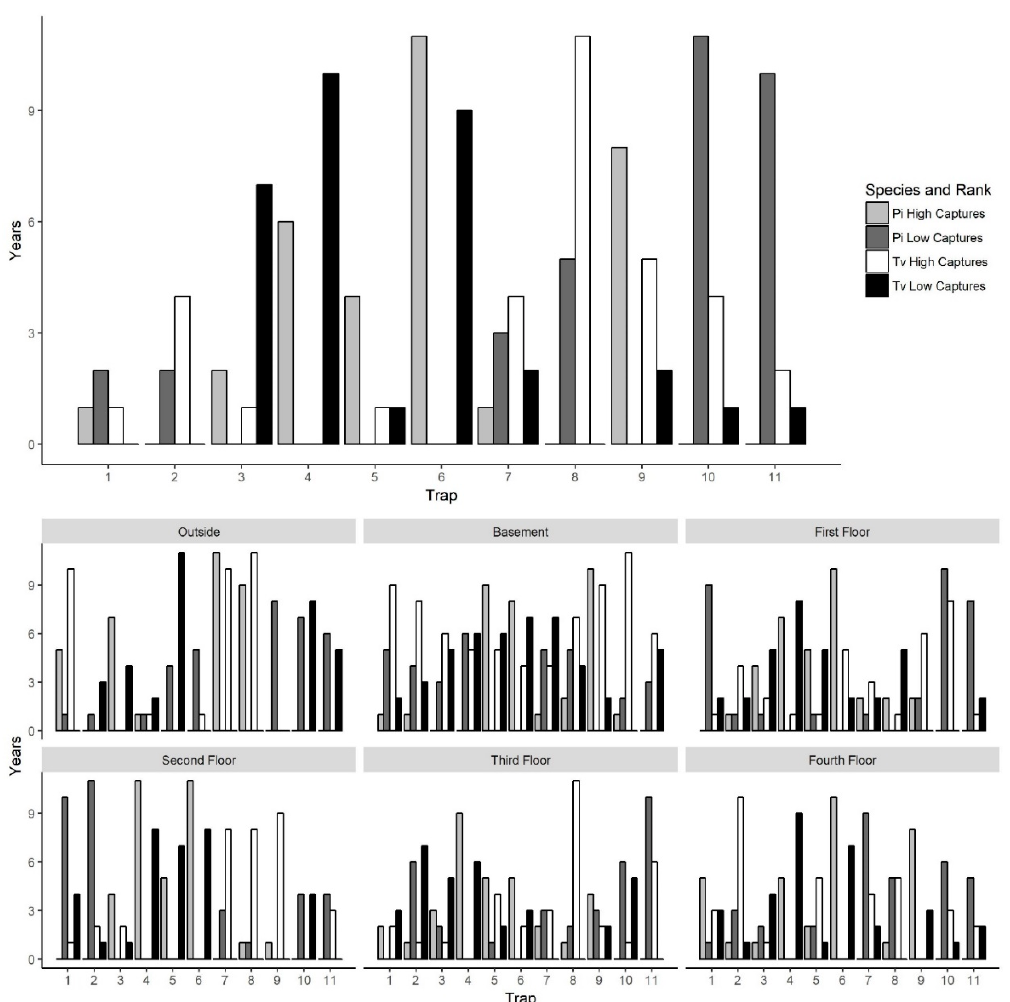
Figure 5. Bar graphs of number of years of trap with high and low numbers of insect captures. Plodia interpunctella is represented by Pi and Trogoderma variabile is represented by Tv. Darker colors (dark gray and black) indicate traps with low captures and lighter colors (light gray and white) indicate high captures. The number of years on the x-axis is based on how many times the trap is in the 3 traps with the highest insect captures or the 3 traps with the lowest insect captures. The top panel is all indoor traps combined and the bottom panels is each location independently.